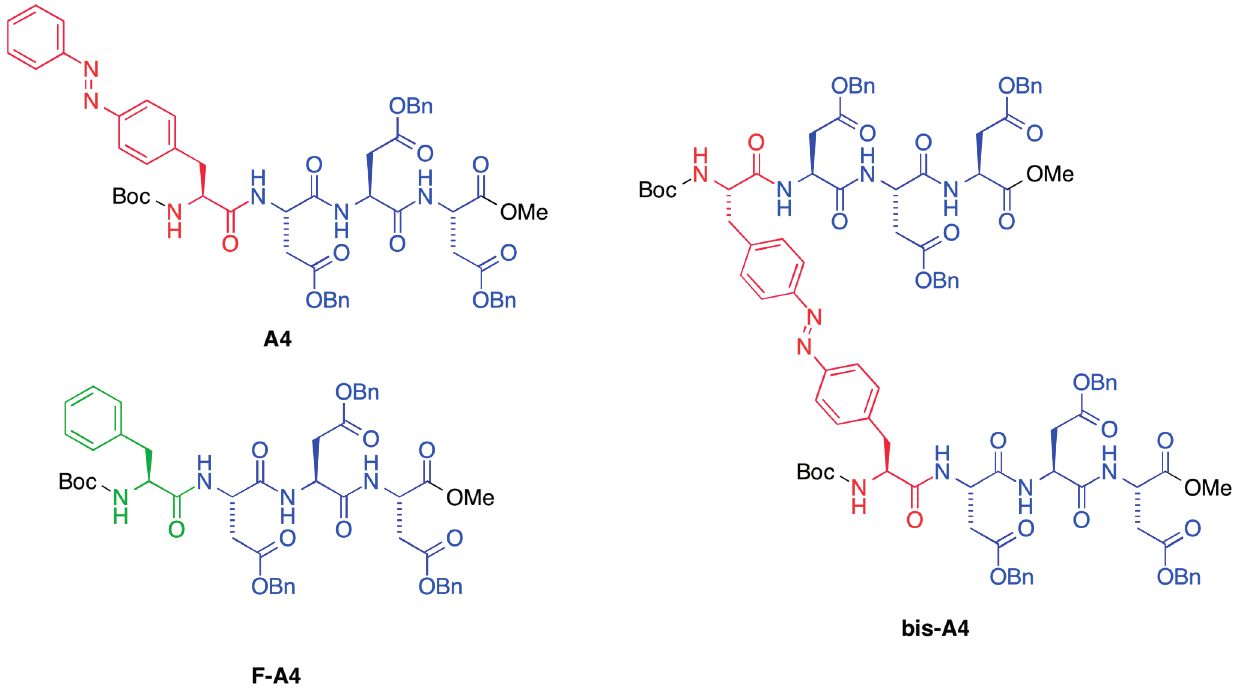
Figure 1. Structure of peptidic gelators used in this work (Bn = CH 2